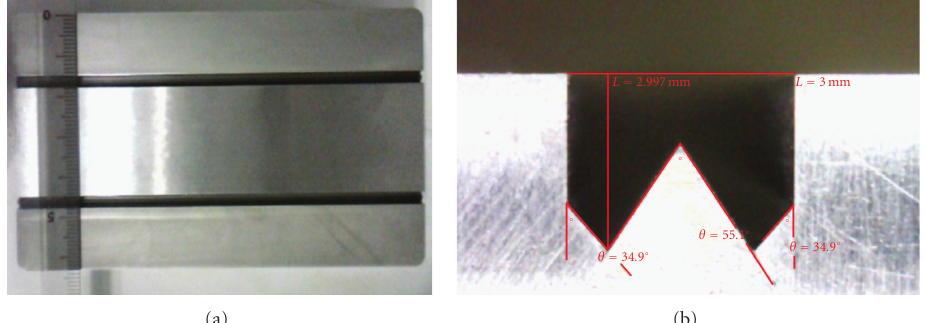
Figure 5: Photographs of top (a) and cross-section (b) of EL mold.